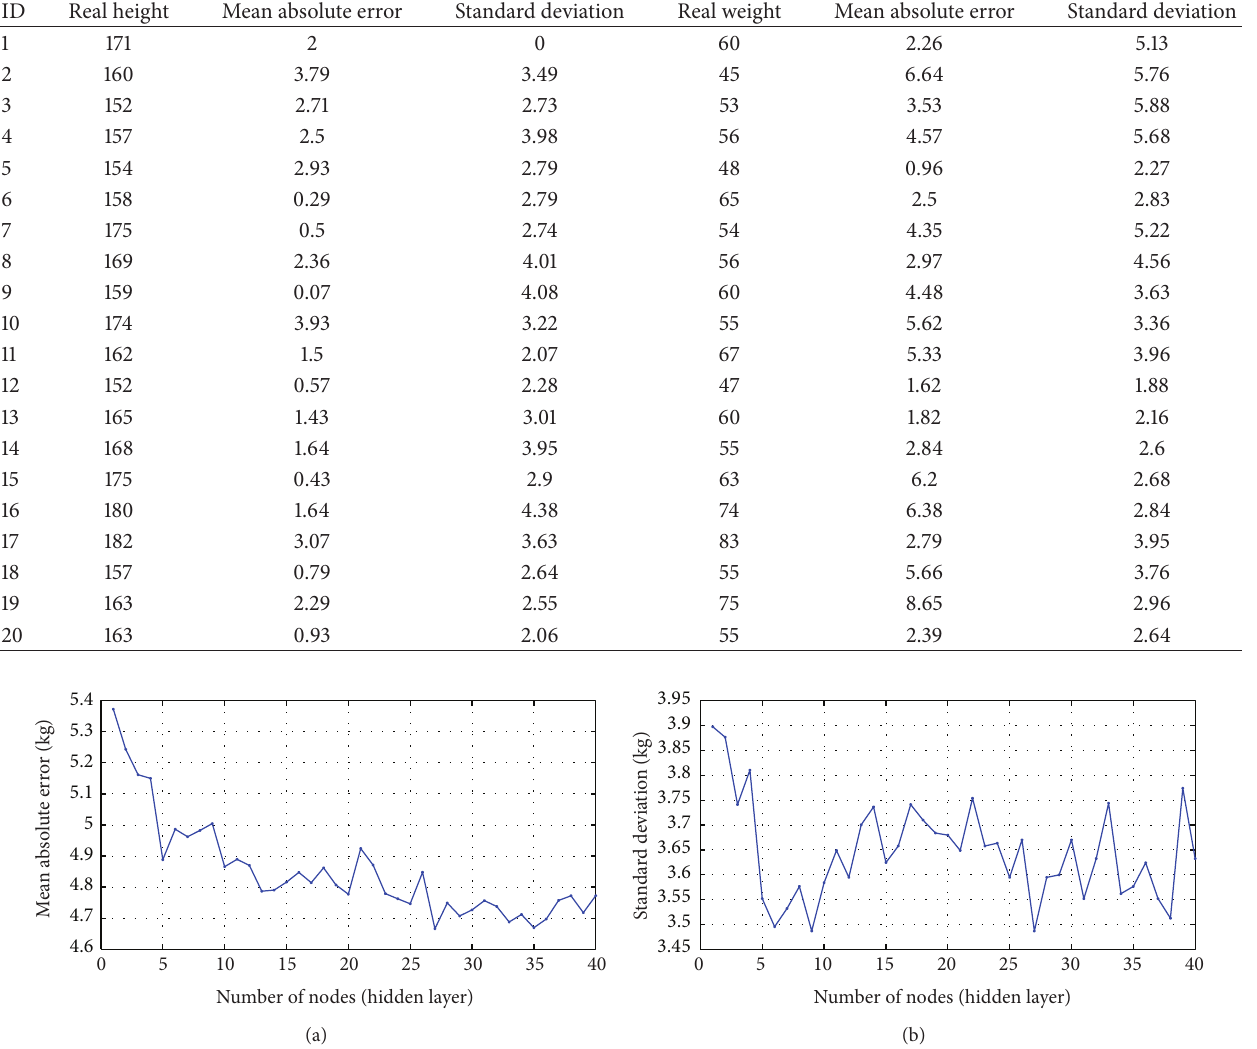
Table 2: Results of height and weight computation of the first 20 subjects in the database.